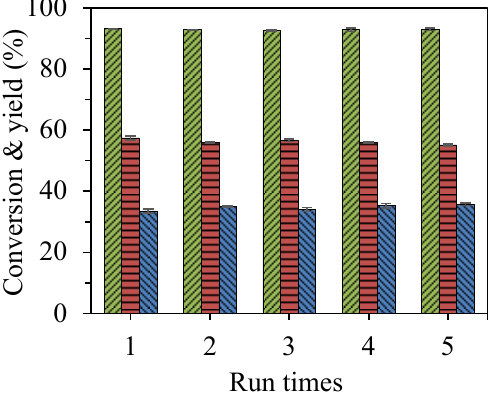
Figure 8. Reusability of 10-Nb/MCS in catalytic conversion of glucose into HMF. (Reaction conditions: Catalyst amount, 0.018 g; glucose concentration, 0.07 M; solvent volume (1:2 v / v water saturated with NaCl: THF), 30 mL; temperature, 190 °C; time, 1 h; N 2 pressure, 10 bar).